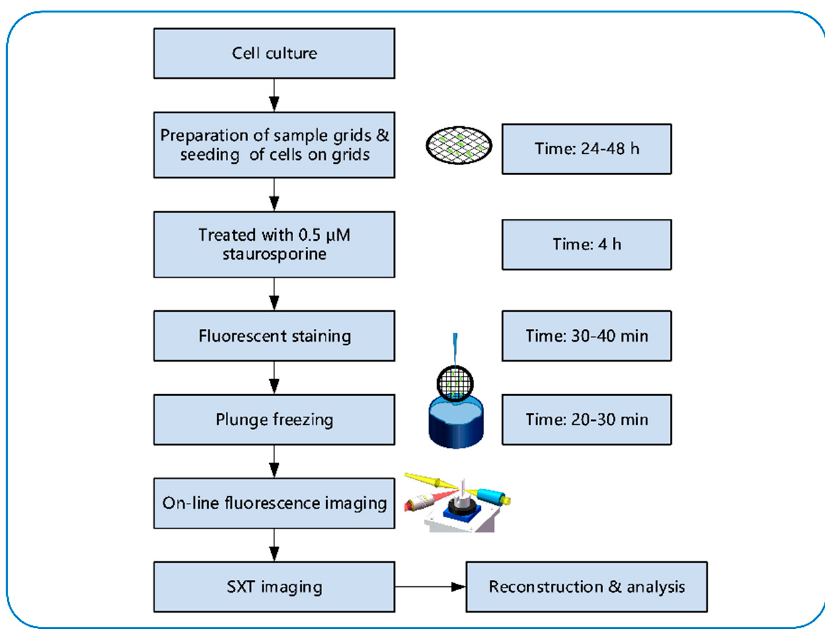
Figure 2. Workflow of the sample preparation and imaging. After the HeLa cells adhered to the grid, the cells were treated with 0.5 µ M apoptotic inducer staurosporine for 4 hours. Fluorescent imaging was used to detect apoptosis.